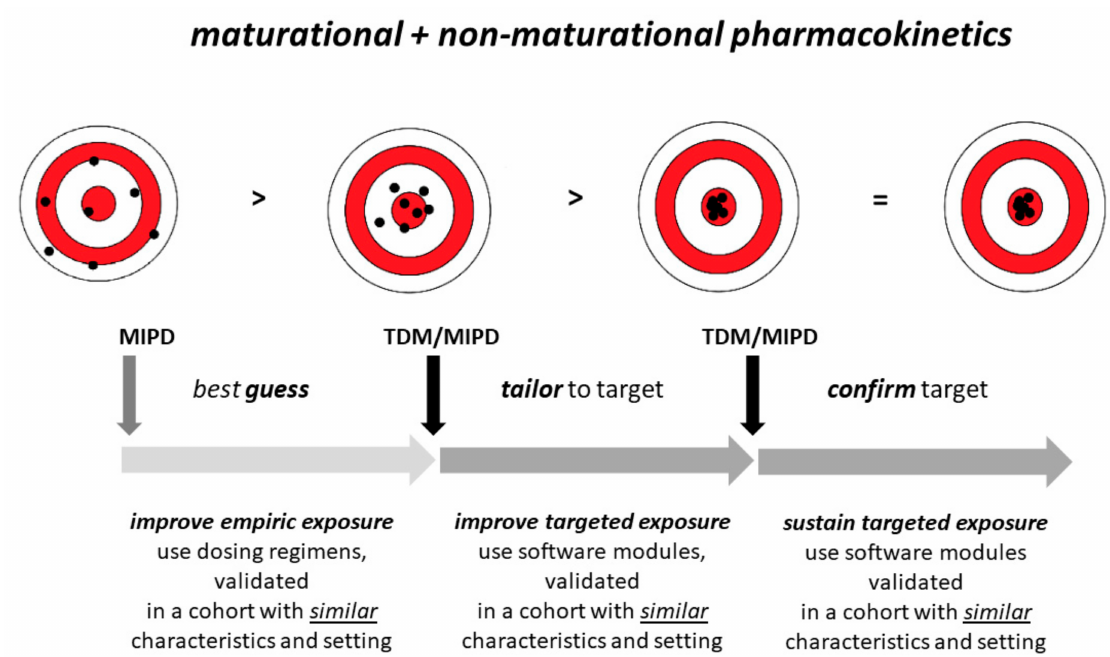
Figure 3. Structured approach to improve target exposure for antibiotics in critically ill neonates and